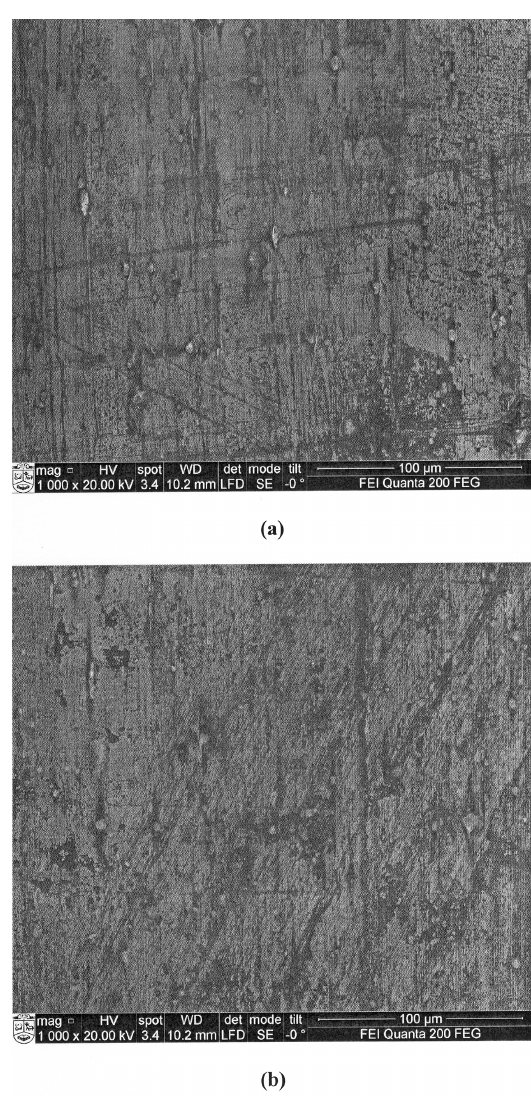
Figure 3: Typical SEM micrographs of surfaces of tapes: a – sample A, b – sample